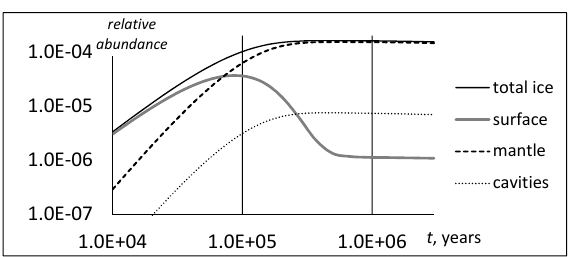
Fig. 1. The relative abundance of water ice, distributed on the surface, compact ice mantle and cavity